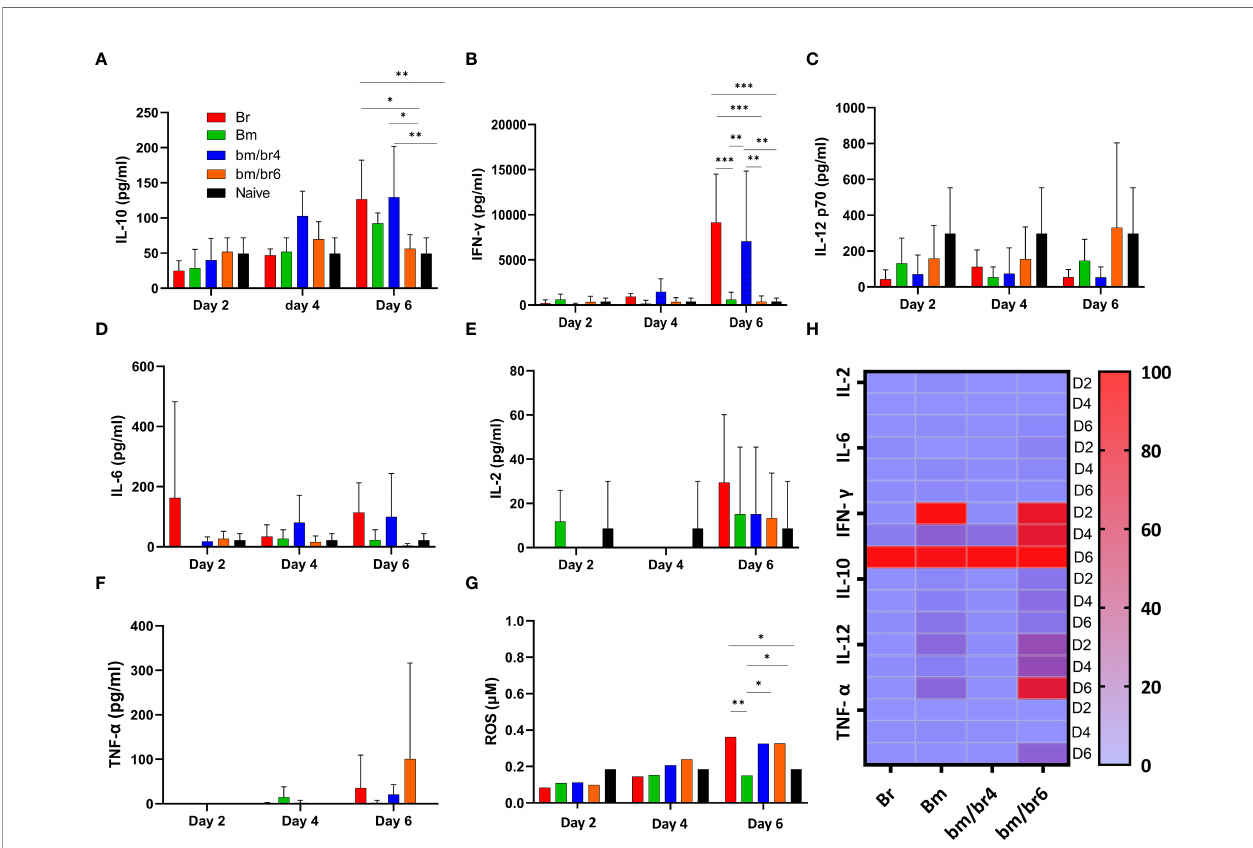
FIGURE 4 | The kinetics of serum cytokines of protected and susceptible mice after B. rodhaini challenge infection. Test mice were initially infected with B. microti and challenge infected with B. rodhaini on days 4 and 6. On day 6 post-challenge infection, serum was collected from all groups and levels of (A) IL-10, (B) IFN- g , (C) IL-12p70, (D) IL-6, (E) IL-2, and (F) TNF- a were measured. (G) ROS levels were determined by measuring serum levels of H 2 O 2 . (H) Heatmap showing the progression of secretion of the six cytokines at timepoints day 2 (reference), 4, 6 pci. The results are expressed as means ± SD. Ordinary one-way analysis of variance (ANOVA) with Tukey ’ s test was used for the statistical analysis. Asterisks indicate statistical signi fi cance (* p < 0.05; ** p < 0.01; *** p <